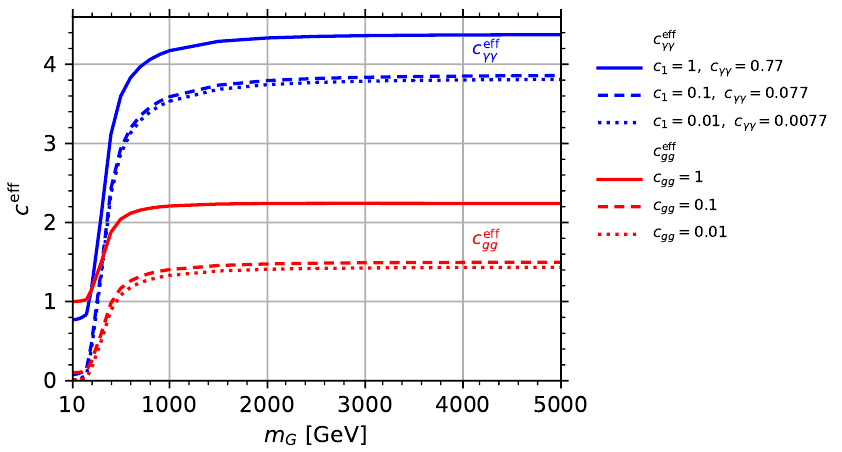
Figure 2 . E(cid:11)ective KK graviton couplings as functions of the KK graviton mass, where c tt = 1 is chosen and the solid, dashed and dotted lines correspond to c 1 and c gg = 1, 0.1 and 0.01, while the blue and red lines are for the e(cid:11)ective coupling between the KK graviton and photons and gluons,